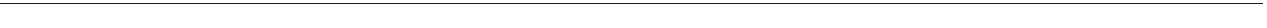
Fig. 8 T. brucei CFAP44 and CFAP43 are necessary for cell survival and proper axonemal organization. a – d Immuno fl uorescence on detergent-extracted cells of parental T. brucei stained with anti-PFR (red) and anti-myc (green) antibodies. e – h Immuno fl uorescence on detergent-extracted cells expressing TbCFAP44 myc and RNAi induced (24 h) for TbCFAP44 ( TbCFAP44 myc RNAi ). Cells showed no or weak myc labeling (green) on the new fl agellum (NF), while the old fl agellum (OF) remained labeled. PFR is labeled in red. Note: cells with a maximum of two fl agella were chosen for clear imaging. i – l Similar RNAi experiments as performed in e – h for TbCFAP43 RNAi in cells expressing TbCFAP43 myc ( TbCFAP43 myc RNAi ). Cells showed no or weak myc labeling (green) on the new fl agellum (NF), while the old fl agellum (OF) remained labeled. PFR is labeled in red. Nuclei and kinetoplasts (mitochondrial genome) are labeled with DAPI (blue). Scale bars = 5 μ m. Insets are enlargement of images of fl agella taken from the main panels and display areas indicated by white arrows (scale bar = 1 µ m). m Growth curves for parental cells, and TbCFAP44 RNAi and TbCFAP43 RNAi cells, non-induced or induced with tetracycline. The graph represents the cumulative number of cells per ml. Error bars represent the standard error from three independent experiments. n Flagellum length measurement of the new fl agellum in cells bearing two fl agella from parental cells, and from cells expressing TbCFAP44 myc and TbCFAP44 myc and induced (24 h) for TbCFAP44 RNAi and TbCFAP43 RNAi, respectively. Flagellum length was measured in cells showing a clear decrease in myc labeling in the new fl agellum. o – t Electron micrographs of stained thin sections of parental cells ( o , r ) bearing one fl agellar pocket (FP) and one fl agellum (*), and of 24 h induced Tb CFAP44 RNAi ( p , s ) and Tb CFAP43 RNAi ( q , t ) cells. s and t are enlargements of p and q , respectively. Scale bars = 100 nm in o – q ; 200 nm in r – t . Note: in TbCFAP44 RNAi and TbCFAP43 RNAi cells, the fl agellar pocket is enlarged and bears more than two fl agella ( p , q ). Some of these fl agella present axonemal defects including displaced and rotated CPC and shifted DMTs ( p , white arrows, s , t